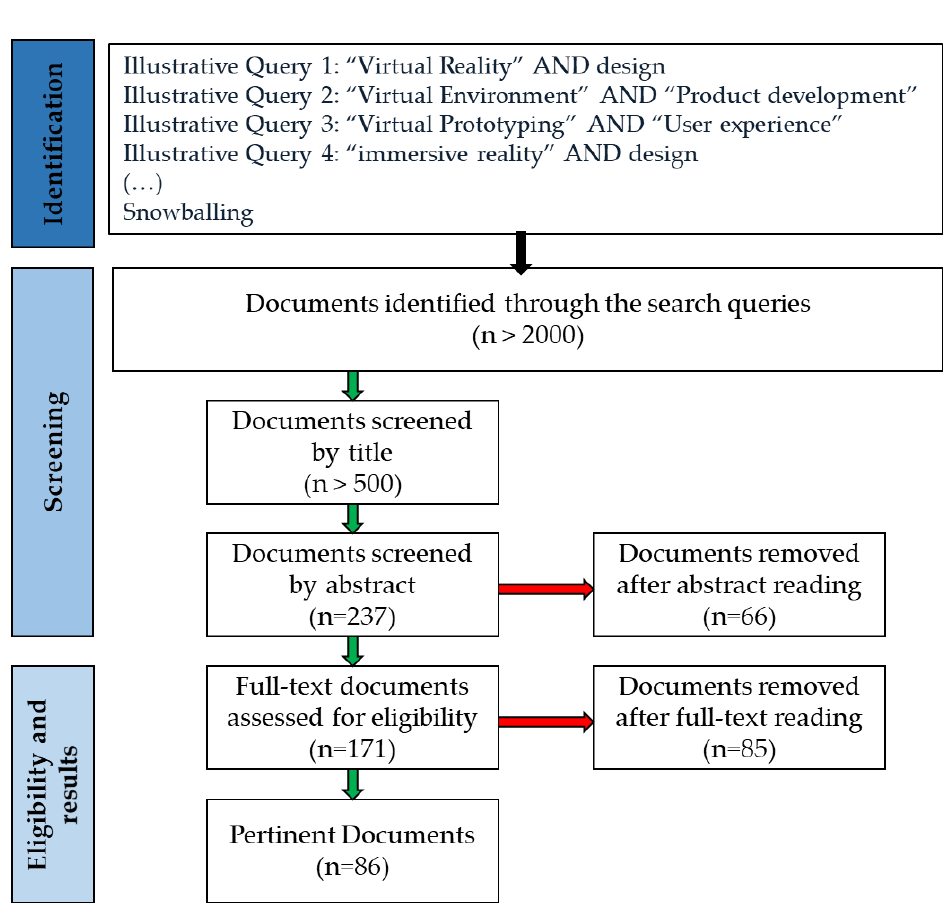
Figure 1. PRISMA diagram showing the selection process of relevant documents describing VR applications in design.